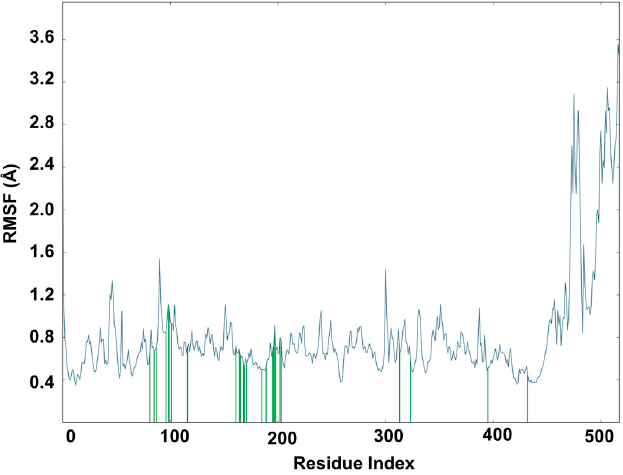
Figure 8. The Root Mean Square Fluctuation (RMSF) plot based on C α atoms of MAO-B. Protein residues that interact with the acacetin 7-methyl ether is marked with green vertical bars.